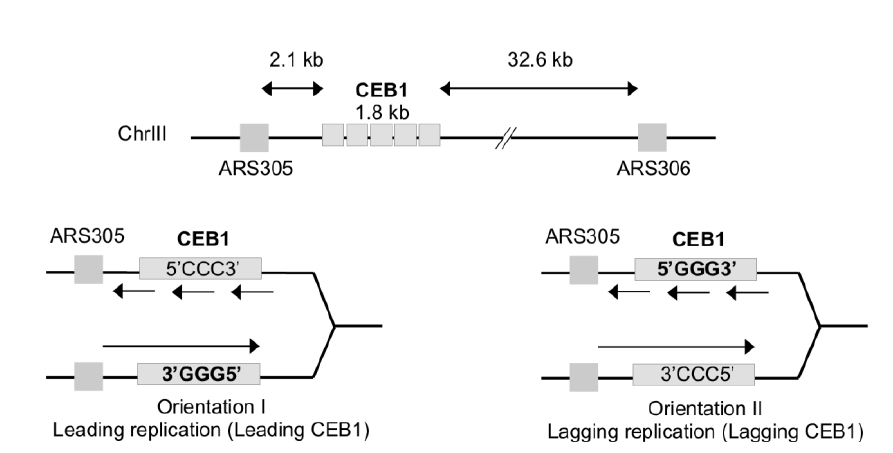
FIGURE 1: Map of the CEB1 insertion within chromosome III at 2.1